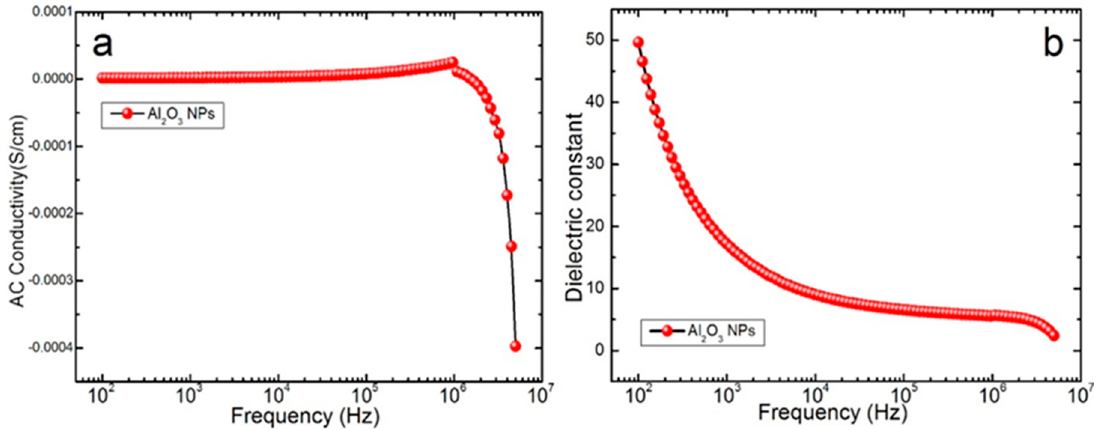
Figure 3. ( a ) Variation of AC conductivity and ( b ) dielectric constant with frequency. Table 2. Variations in electrical conductivity parameters of Al 2 O 3 and SiO 2 with applied frequency.